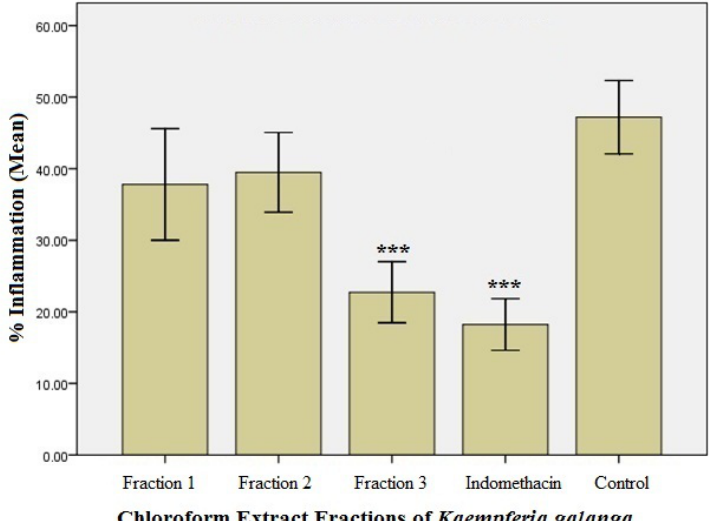
Figure 2. Percentage (%) inflammation observed in the fraction-treated rats after 3rd h of carrageenan administration (n =